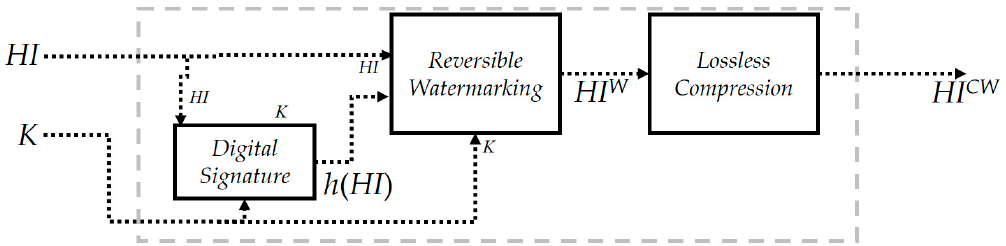
Figure 1. The architecture of the proposed framework.